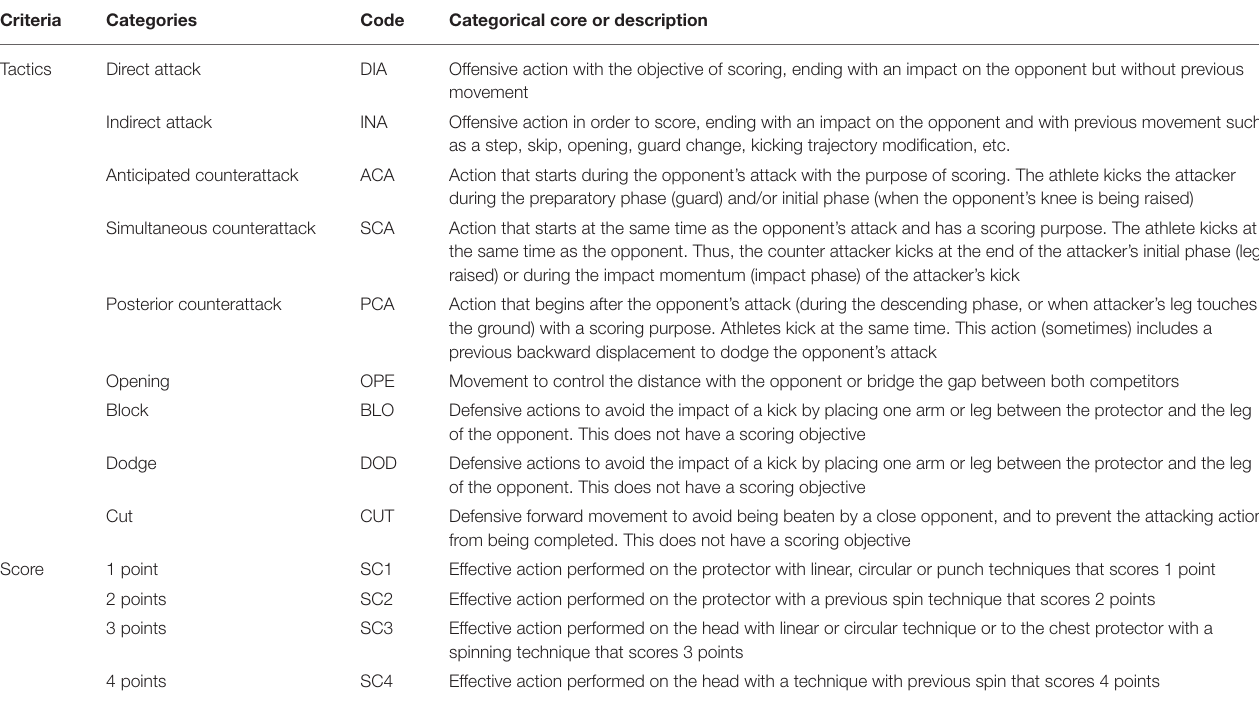
TABLE 1 | Criteria, categories, codes and categorical core of the observational tool used.